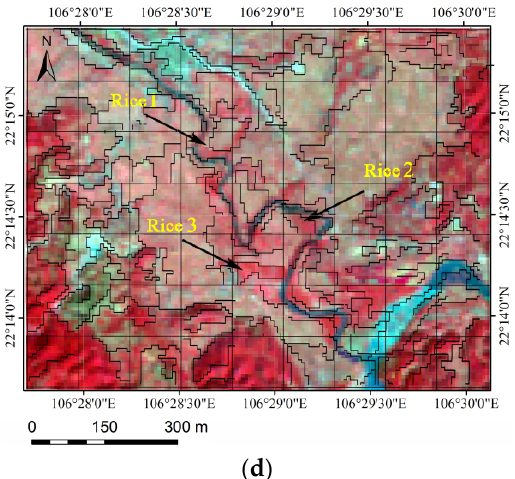
Figure 9. Fractal rice field in the North East region, in which rice was planted nearby the river: ( a ) the Landsat TM image for 5 April 2009, in the North East region. The grid in black is the corresponding extent of a pixel in MODIS pixel.; ( b ) The Google Earth image obtained on 18 December 2013; ( c ) the NDVI curve of three points in the rice area; ( d ) the segmentation result based on multiresolution segmentation and the TM image.